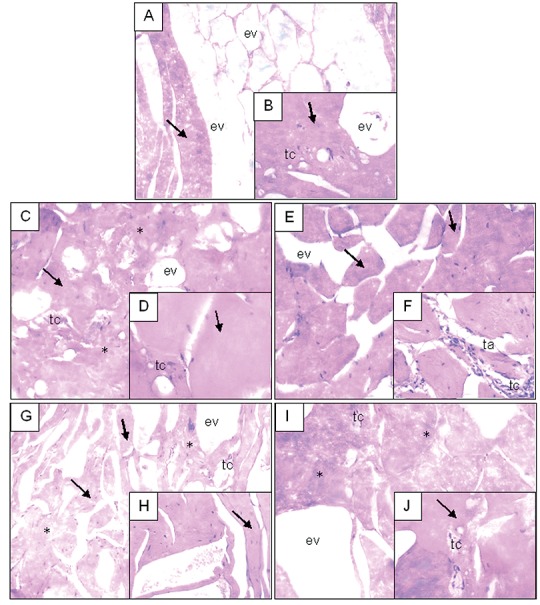
Photomicrographs of hamburger formulations with a detail to the right. Legend: A and B=standard, C and D=formulation T1, E and F=formulation T2, G and H=formulation T3, I and J=formulation T4. Muscle tissue (arrows), adipose tissue (ta), conjunctive tissue (tc), tissue disorganization (*), and empty spaces (ev). Magnification: 10× (A, C, E, G and I) and 25× (B, D, F, H and J)